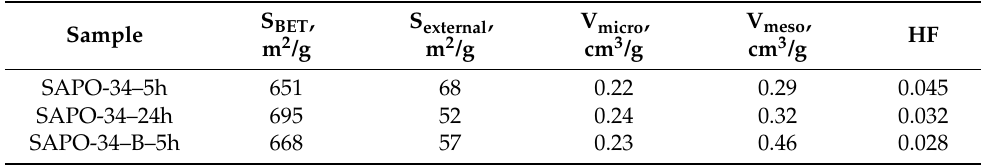
Table 1. Texture properties of